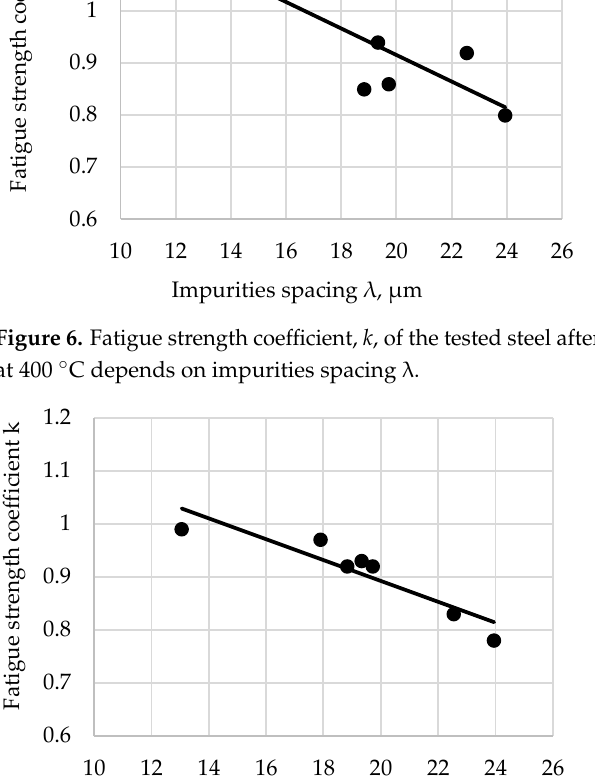
Figure 7. Fatigue strength coefficient, k , of the tested steel after hardening from 880 °C and temper- ing at 500 °C depends on impurities spacing λ.